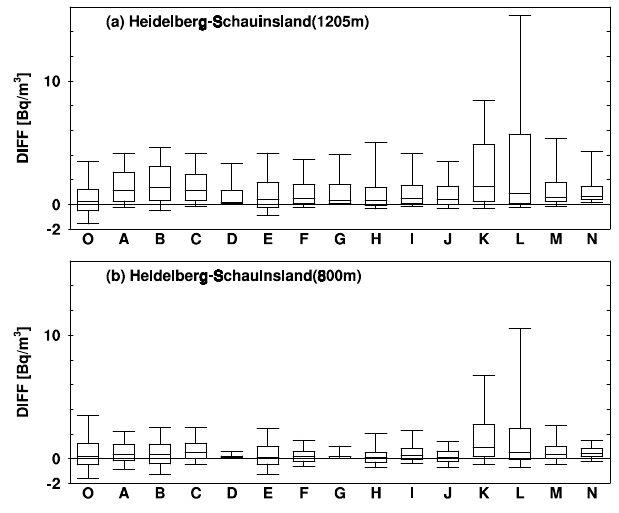
Fig. 7. Departure of six hour (12:00–17:00UTC) concentrations of Heidelberg from those at Schauinsland. Measurements are indi- cated with “O”. Departures in each model are indicated with letters as listed in Table 1. The first decile, the first quartile, the median, the third quartile and the ninth decile are shown with box and whiskers. Concentrations at Schauinsland are sampled at both 1205m (a) and 800m (b)